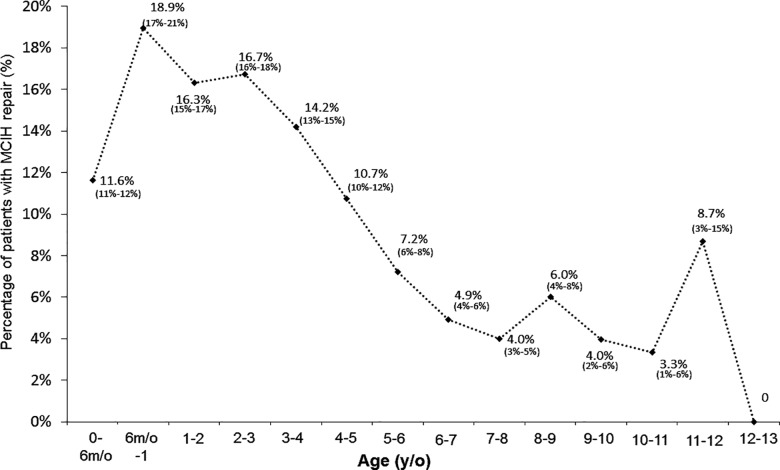
The rates of metachronous contralateral inguinal hernia among different age groups.